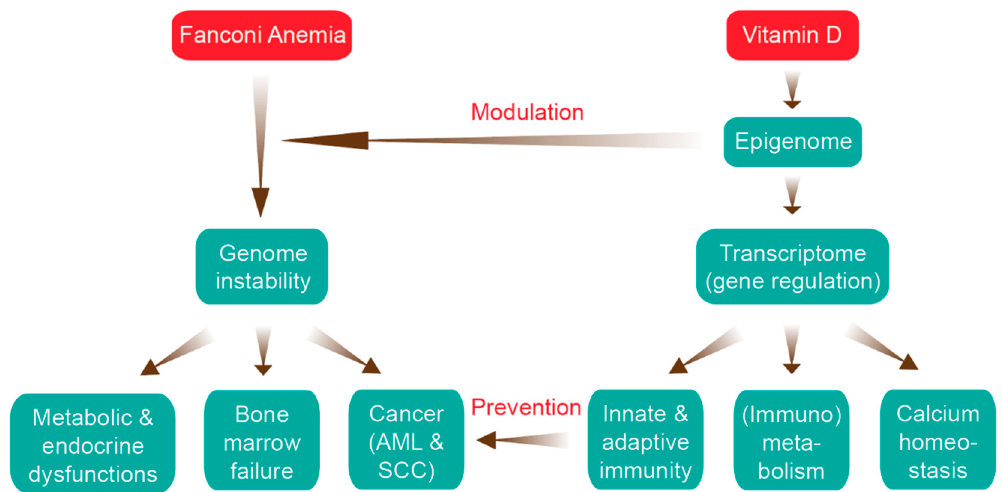
Figure 1. Relation of Fanconi anemia (FA) and vitamin D. The major clinical features of FA (left) are aligned with the key functions of the vitamin D system (right, more details in Figures 3 and 4). There are two main ways that vitamin D can interfere with the FA disease progression: epigenetic modulation of genome instability and prevention of cancer onset via activation of the immune system. AML, acute myeloid leukemia; SCC, squamous cell carcinoma.